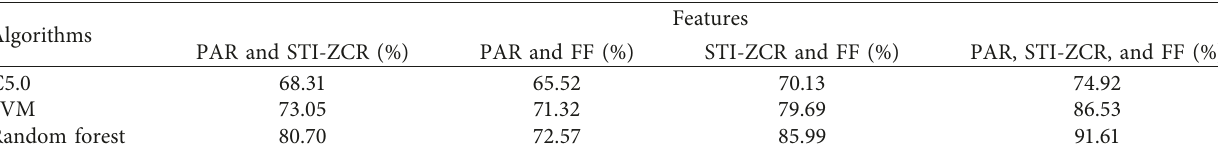
Table 2: Recognition of three microstates with different